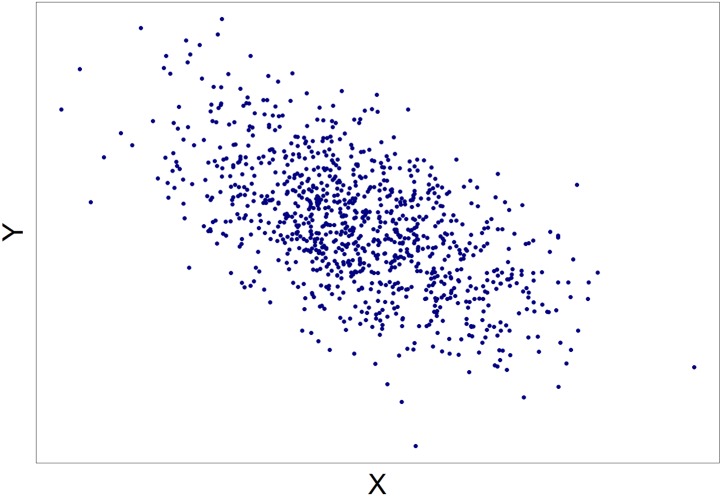
An example of a scatterplot seen by the participants.In this case ρ =  − .55.